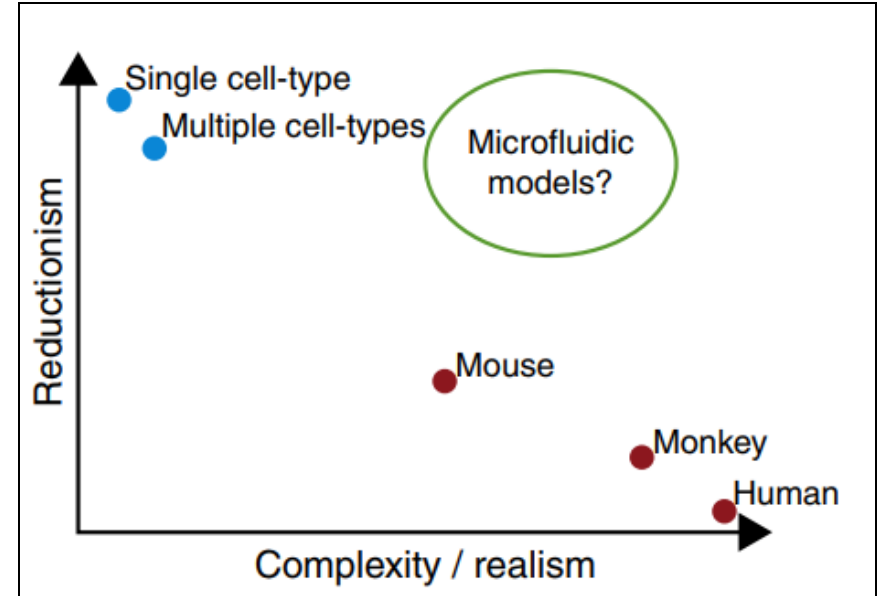
Figure 4. Microfluidic devices as models in which they provide conditions similar to in-vivo animal models and in-vivo models still retaining the simplicity of in-vitro testing. Adapted from Björnmalm et al.